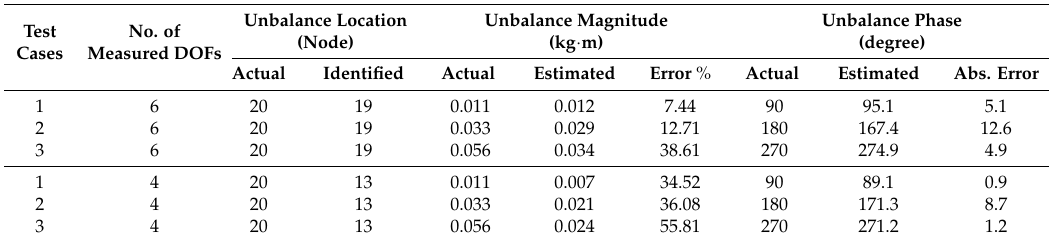
Table 9. Unbalance magnitude and phase estimation for the steel tube roll using equivalent load minimization using six and four measured coordinates.